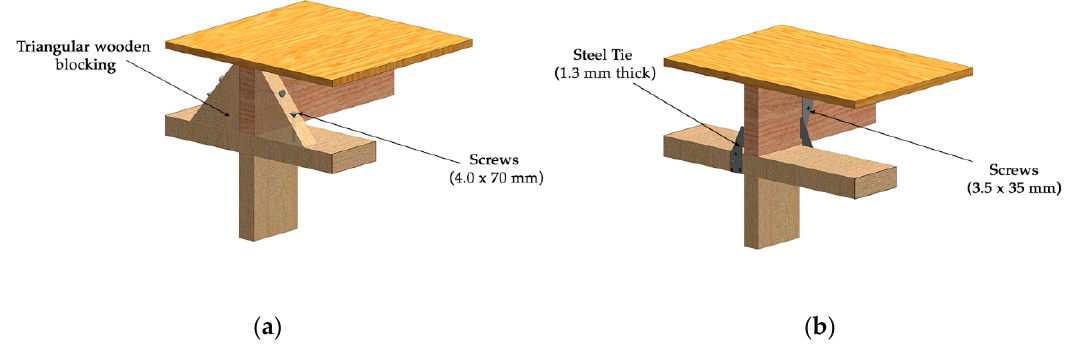
Figure 3. ( a ) Wood-based wall-to-joist connections; ( b ) steel-based wall-to-joist connections. Table 2. Nomenclature, dimensions, and support details of laboratory timber floors.